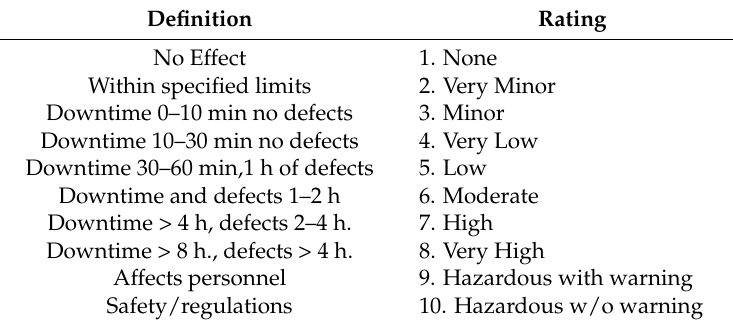
Table 1. Ranking for the severity of each failure